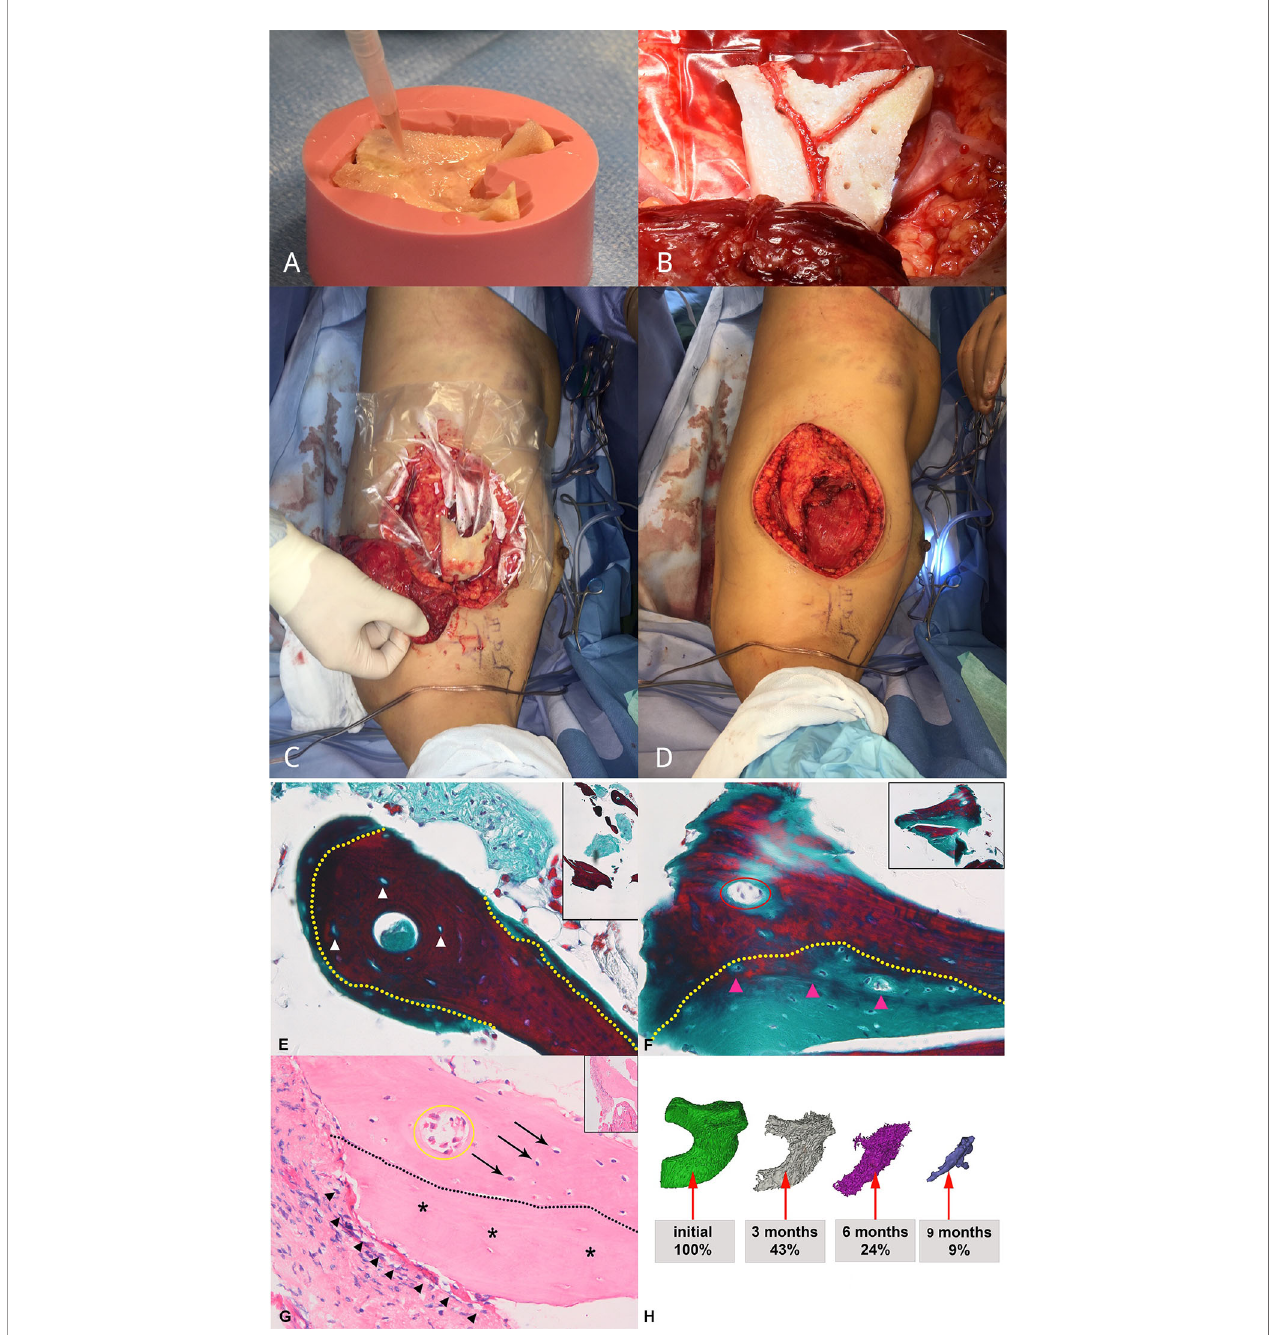
FIGURE 2 | Graft prefabrication and histological analysis (bone biopsy at moment of transfer at week 32) and volume assessment over time. (A) 3D scaffold of devitalized bone manufactured to match the patient ’ s defect size and shape and seeded with SVF cells and BMP-2. (B) Ectopic implantation with serratus AV bundle. (C, D) Construct with vascular pedicle before and after being wrapped in split latissimus muscle. (E, F) High magni fi cation of representative fi gures of bone biopsy after staining with Masson Trichrome. The Tutoplast ® scaffold is characterized by purple staining, representing mature bone and cellular lacunae (white arrowheads), showing devitalized bone tissue. Newly formed bone tissue, represented by light green color, is deposited on the Tutoplast ® scaffold and contains nuclei (pink arrowheads). The yellow dashed line delineates the original scaffold material and apposition of newly formed bone. A vessel (red circle) demonstrates that the scaffold is vascularized. (G) Overview fi gure shows appositional bone growth on the Tutoplast ® scaffold (asterisk). Osteocytes (arrows) are visible in the newly formed bone. The proportion of scaffold vs. new bone formation is close to 50:50. A blood vessel is present within the newly formed bone (yellow circle). Osteoclasts (full arrowheads) fringe the Tutoplast ® scaffold (asterisks), which shows clear signs of degradation at site of interaction. There is no major osteoclast in fi ltration at the level of the newly formed apposed bone and no sign of degradation visible. (H) CT-reconstruction and volume calculation show volume decrease over